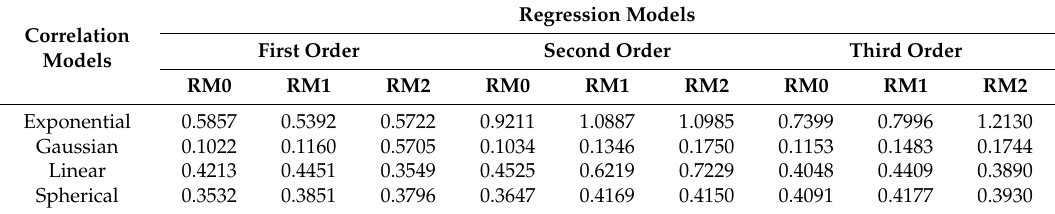
Figure 8. The iteration process for searching the best θ . Table 3. Errors between actual measured and simulated MSs with 21